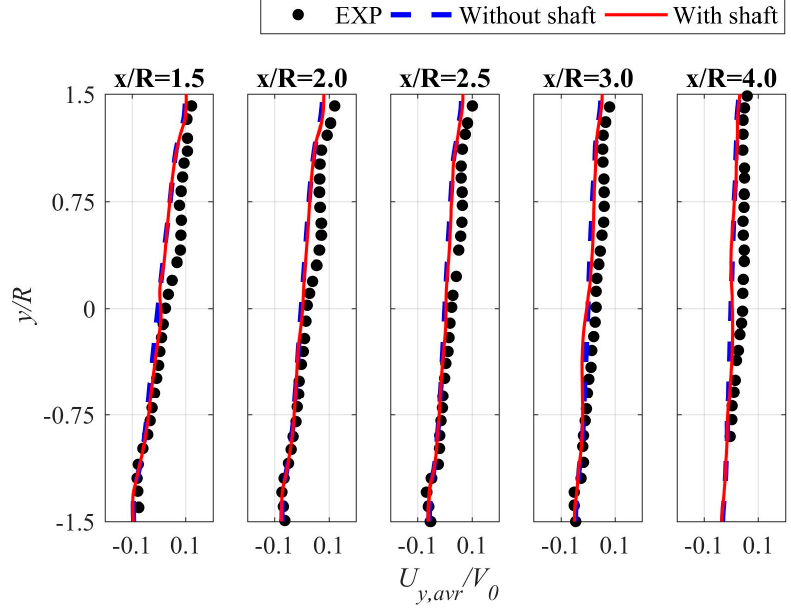
Figure 7. Velocity profiles of the U y component at a few x / R locations downstream behind the rotor. Velocity profiles U x,avr calculated for both rotors di ff er slightly compared to experimental